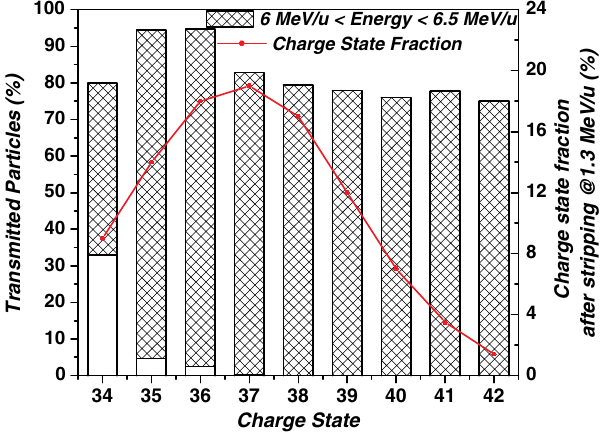
FIG. 5. Transmission efficiency of multiple charge state.